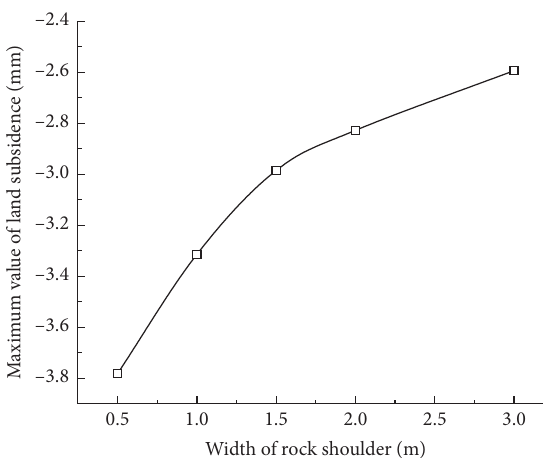
Figure 12: Influence of rock-shoulder width on maximum land subsidence.